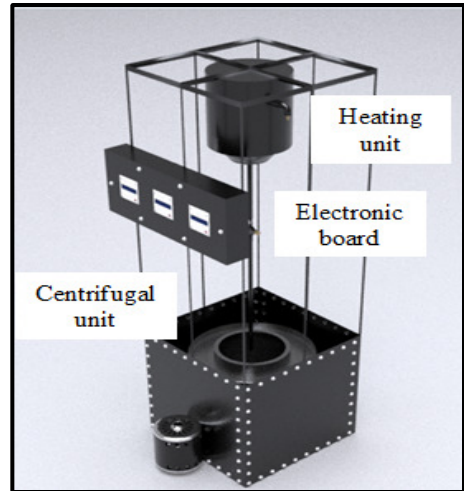
Fig. 1. The design of laboratory production line.